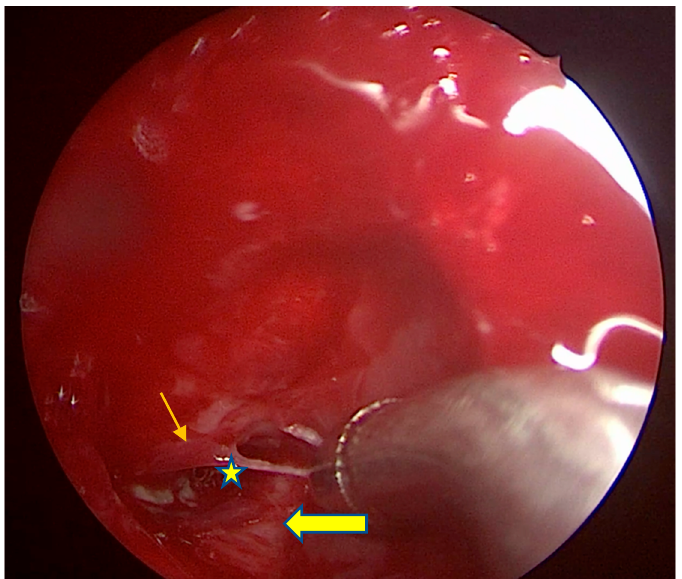
Figure 2. The view into the right sphenoid sinus. Thin arrow represents the foramen rotundum. Thick arrow represents the vidian canal. Star represents the tight opening into the lateral recess. The curved suction tip is too large to pass through the narrow opening into the lateral recess.